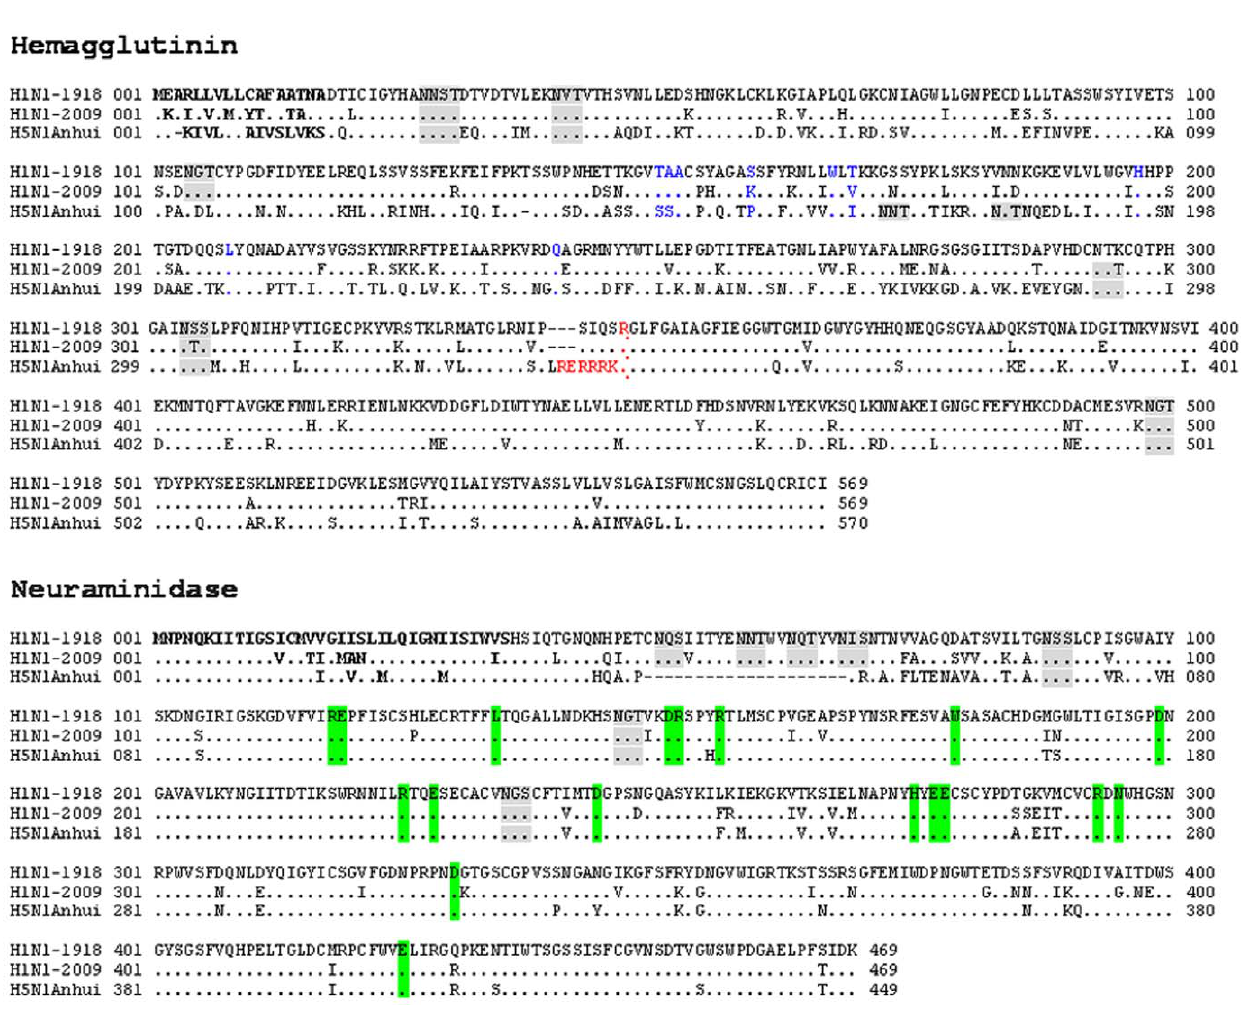
Of the 569 aas in HA, 79 (13.88%) and 200 (35.15%) aa differences were detected in the HAs of the 2009 and H5N1 strains compared to those of the 1918 strain, respectively (Fig. 5).